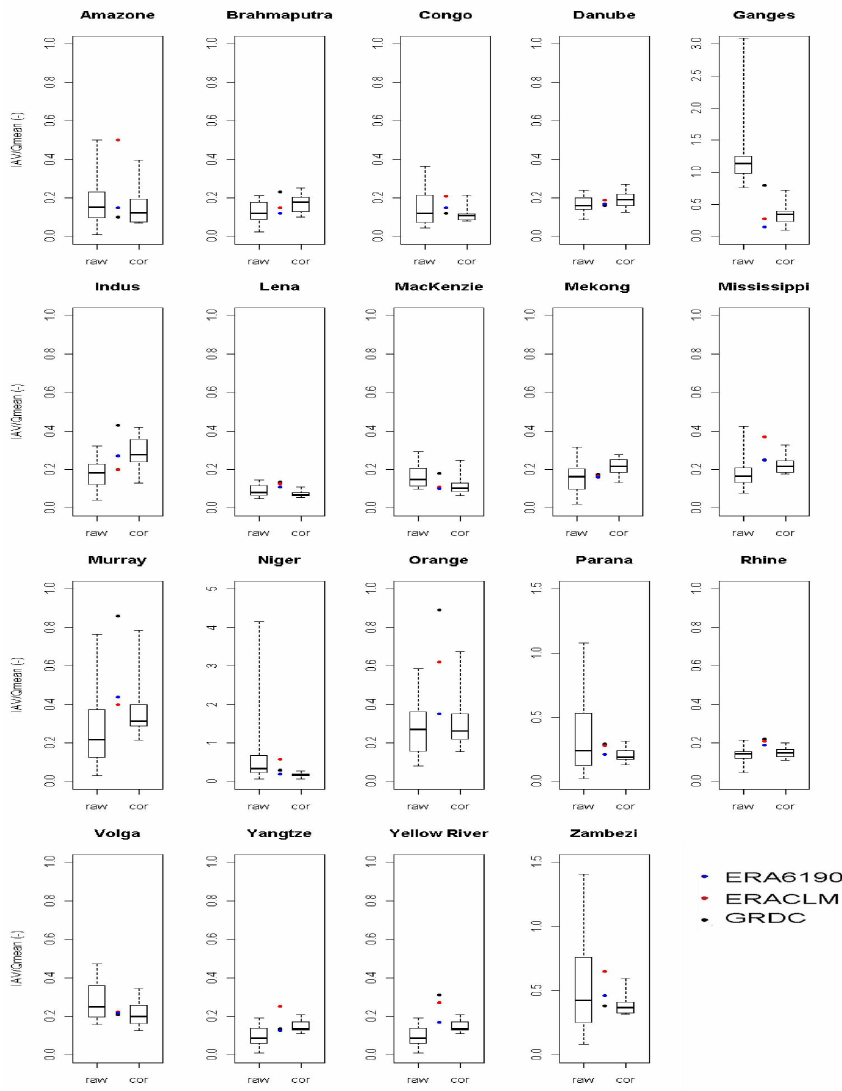
Figure 5: Thirty year average relative inter-annual variability values (IAV /Q (–)) for the ensemble of non-bias corrected GCM runs (raw) and bias-corrected GCM runs (cor; boxes are drawn between the quartiles and whiskers represent minimum and maximum values), the ERA6190 run (blue points), the ERCLM run (red points) and the GRDC observations (black points).